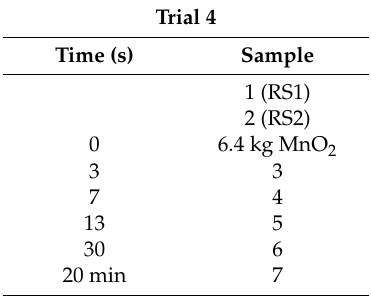
Table 4. Experimental procedure for Trial 4.